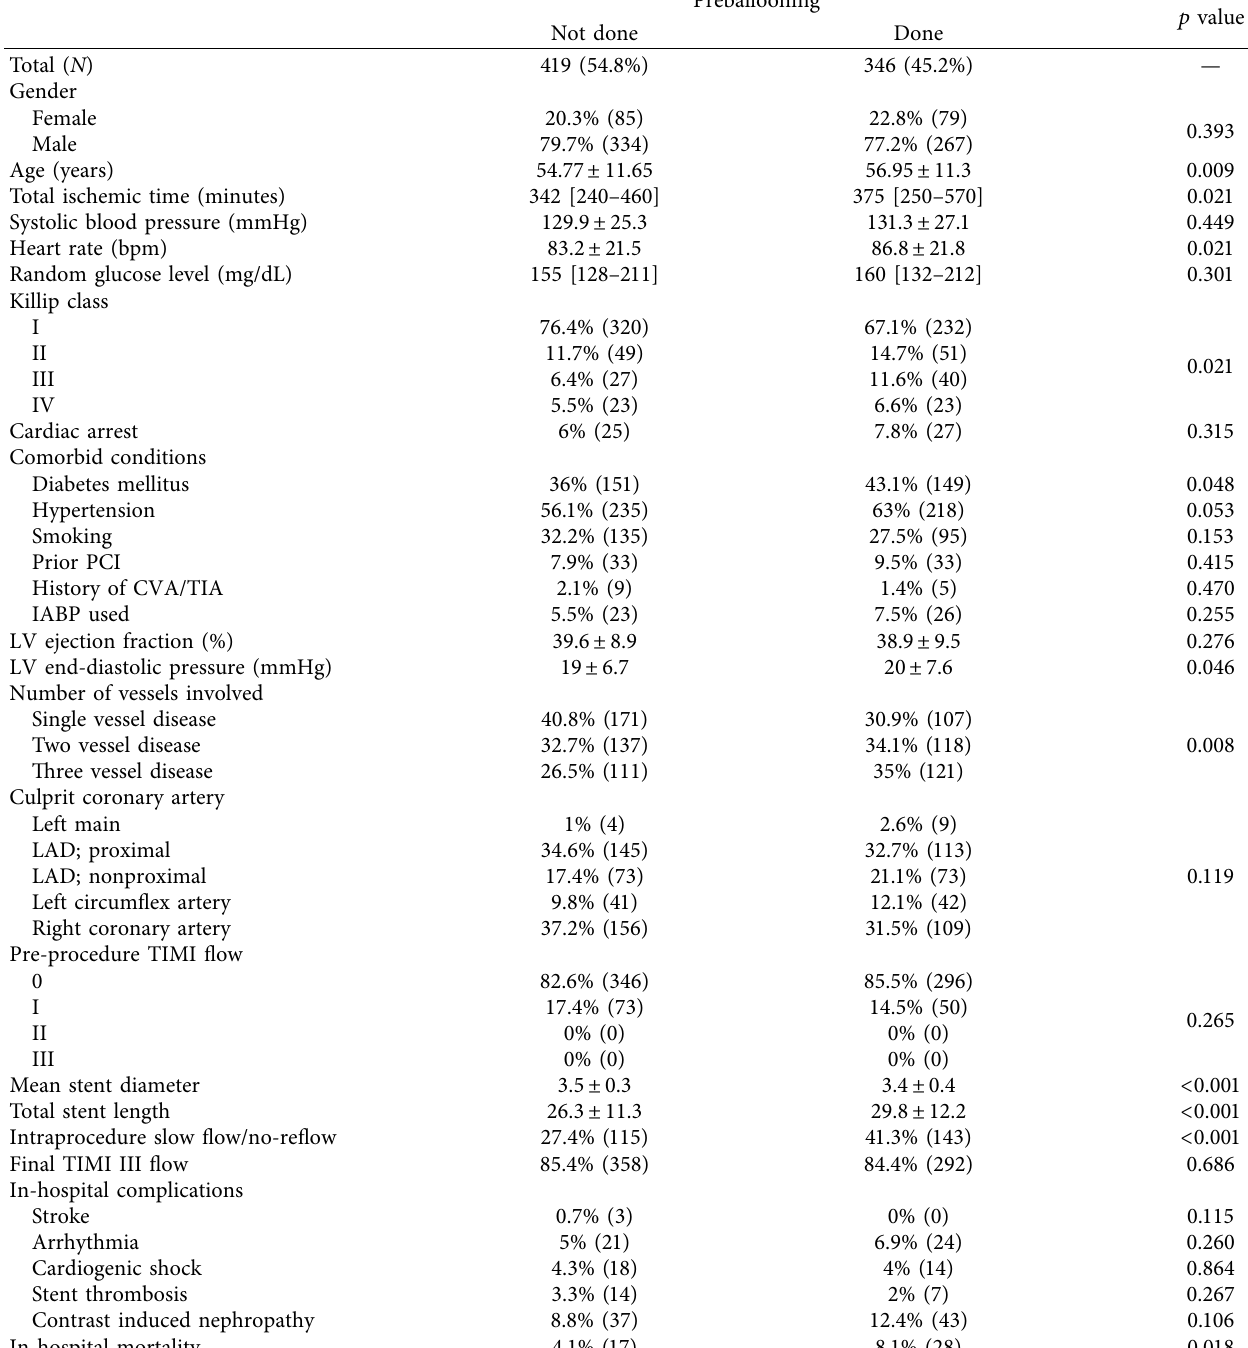
Table 1: Demographic, clinical, and angiographic characteristics and postprocedure in-hospital complications and outcomes stratifed by predilation ballooning